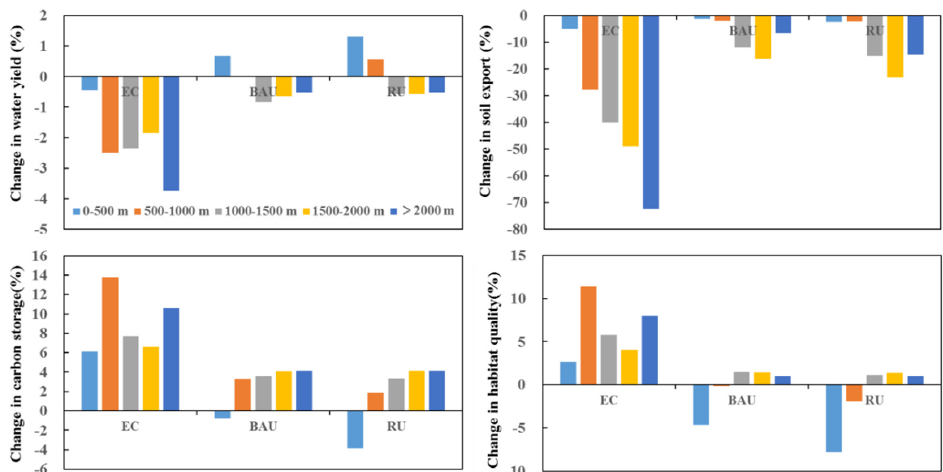
Figure 7. The changes in ecosystem services under the three scenarios at different altitudes. Negative changes indicate a decline in specific ES in a specific scenario, while positive changes present an increase in specific ES in a specific scenario.